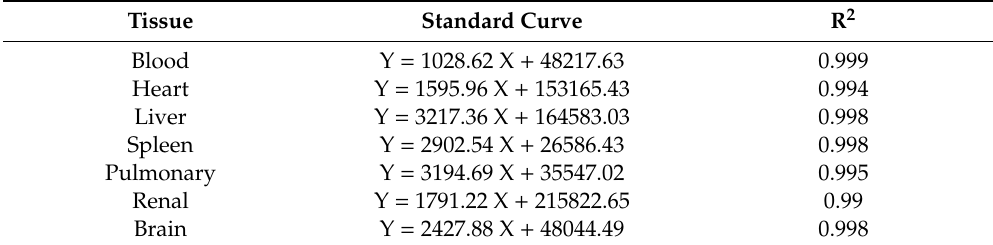
Table 2. The standard curve of FITC-fucoidan in tissues. Tissue